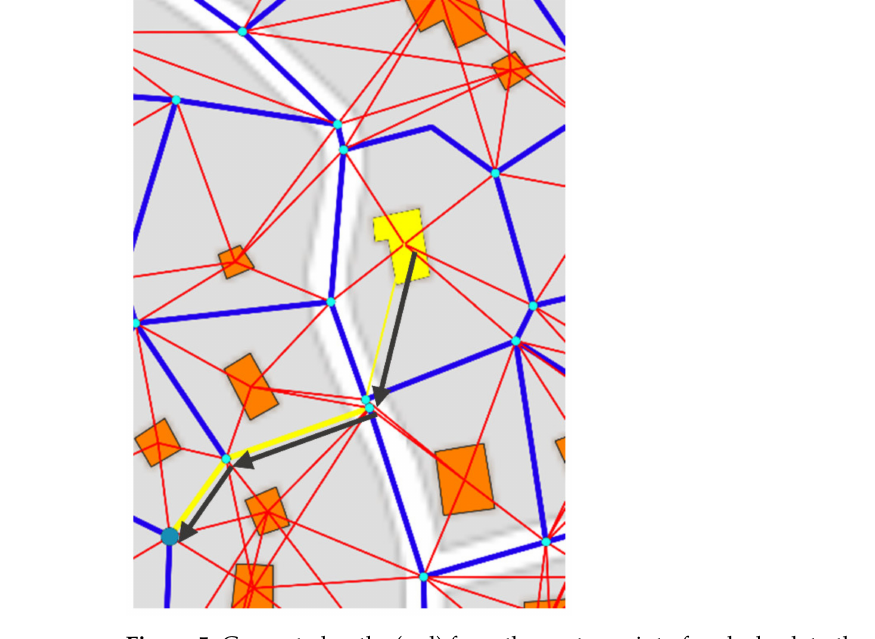
Figure 5. Generated paths (red) from the center point of each shack to the respective surrounding nodes (cyan) of the maximum possible network (blue) (basemap and buildings/polygons: